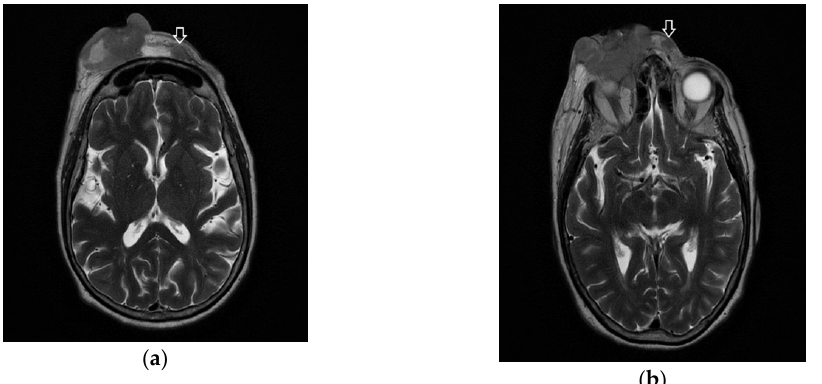
Figure 4. Ax T1 FSE non-enhanced ( a ) and sagittal T1 FSE contrast-enhanced with fat-saturation sequence ( b ). Inhomogeneous enhancement of the lesion, with superficial tissue origin and invasion in the right orbit.